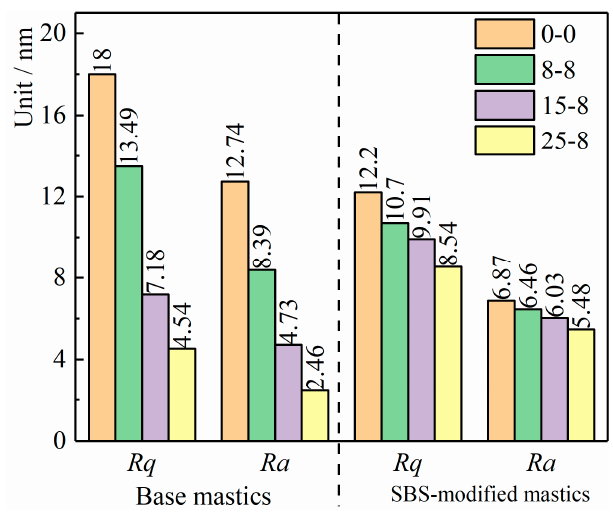
Figure 15. Roughness statistical analysis of the mastics.